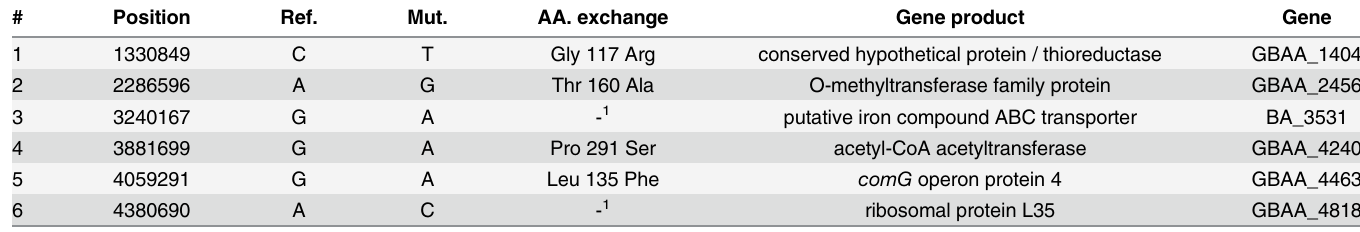
Table 7. Predicted functional consequences of SNP polymorphisms on the translational level. The SNP numbers (#), positions in the reference and the respective variant alleles for the SNP (Mut.) and the reference (Ref.) are shown as well as the potential amino acid (AA.) changes in the affected gene products and the gene